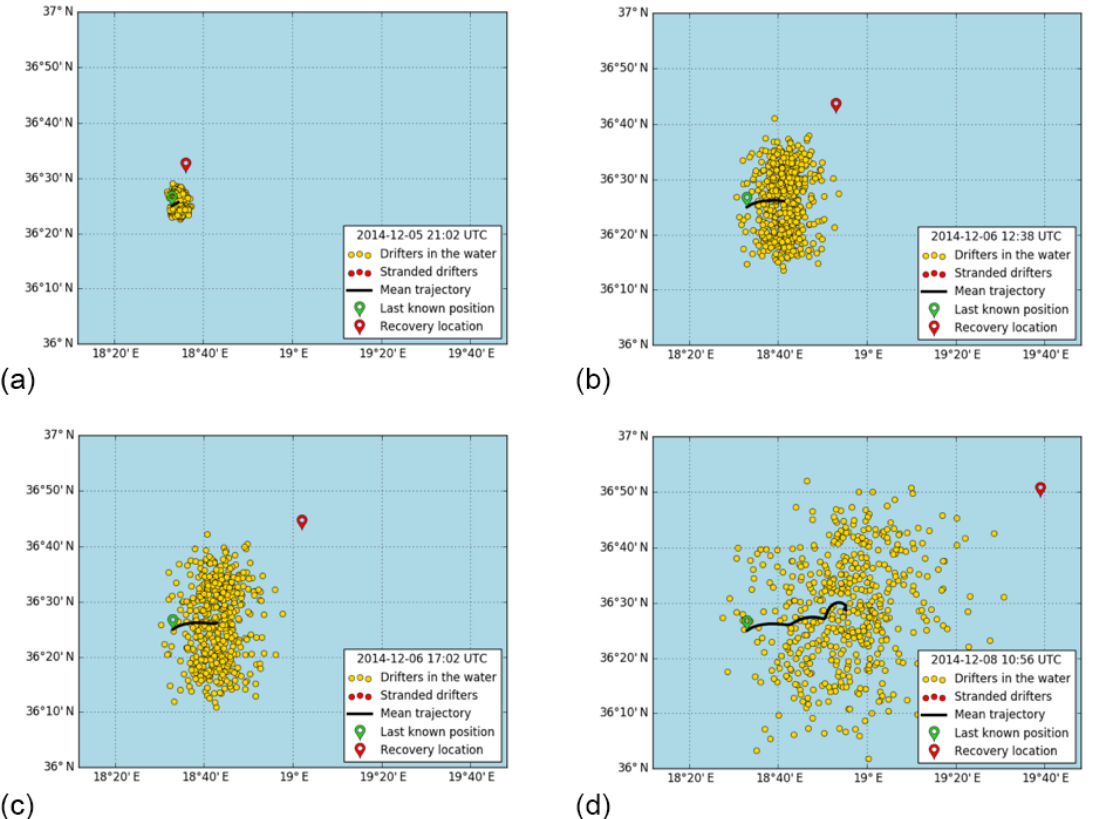
Figure 13. Results of the “migrantship2” simulation done using OCEAN-SAR showing the positions (yellow points) of the particles (a) after 5h of simulation, (b) after 20h of simulation, (c) after 25h of simulation and (d) at the end of the simulation 10:57UTC on 8 December 2014, after 66h. The red place marker indicates the observed position of the ship at each time. The green place marker represents the position in which the ship was found but when it was not possible to rescue. The black line shows the mean trajectory of the launched